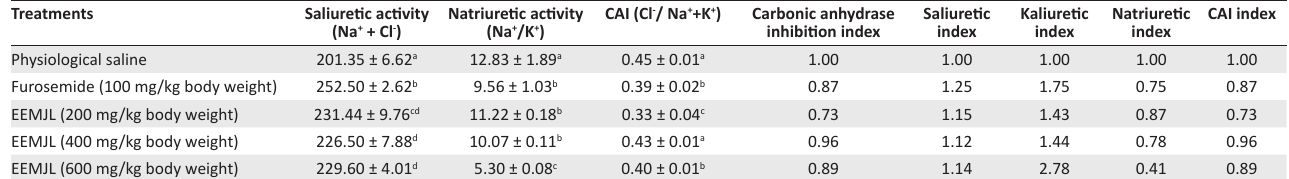
TABLE 3: Computed urinary indices of male rats after oral administration of ethanol extract of Mirabilis jalapa leaf.